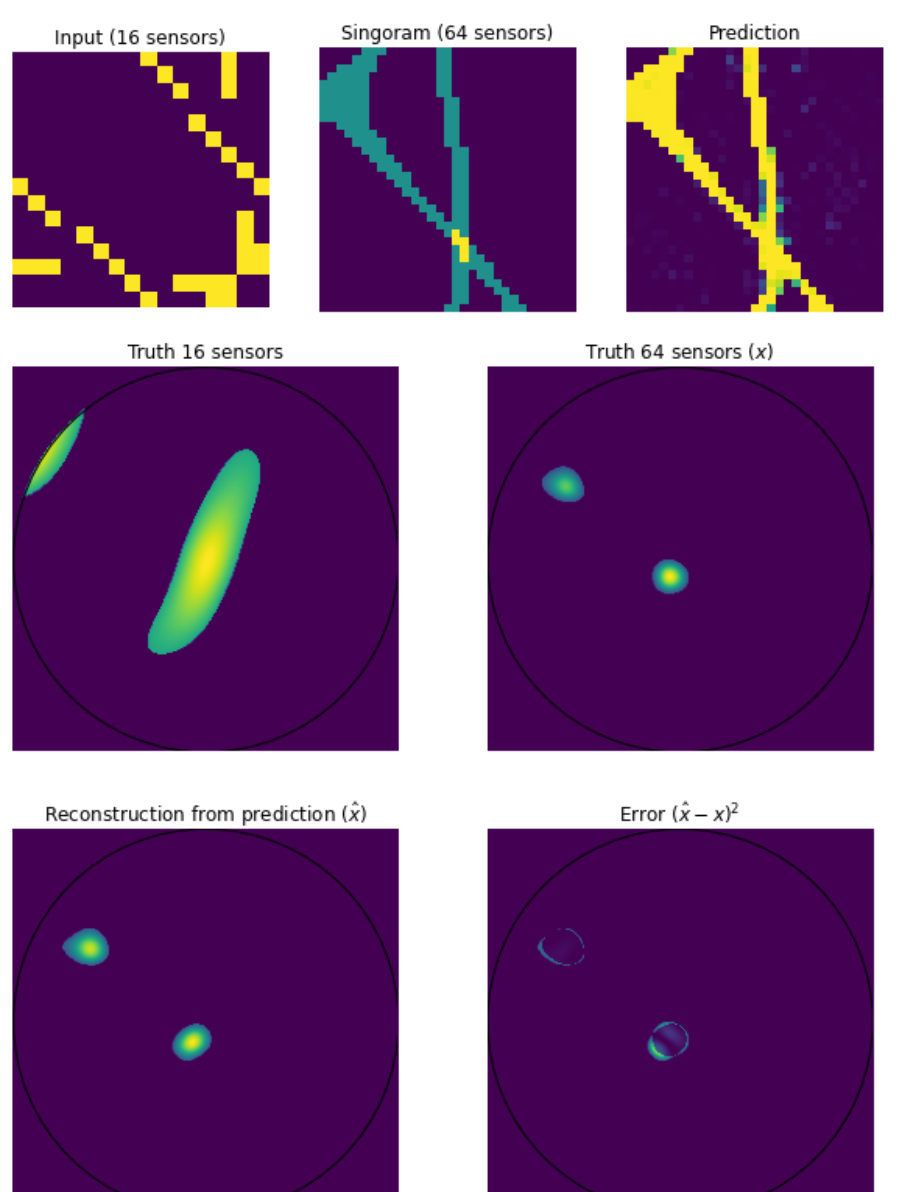
Figure 5. Results obtained with the data from the simulation. The top left image is 16 sensors simulation of measurement. The top middle is a sinogram obtained from 64 sensor measurements. The top right predicts 64 sensor sinograms from 16 sensor measurements. The middle left is a Reconstruction from 16 sensor measurement data, middle right is a reconstruction from 64 sensor measurement data. The bottom left is a reconstruction from the prediction, bottom right is an error between reconstruction from prediction ( ˆ x ) and truth x